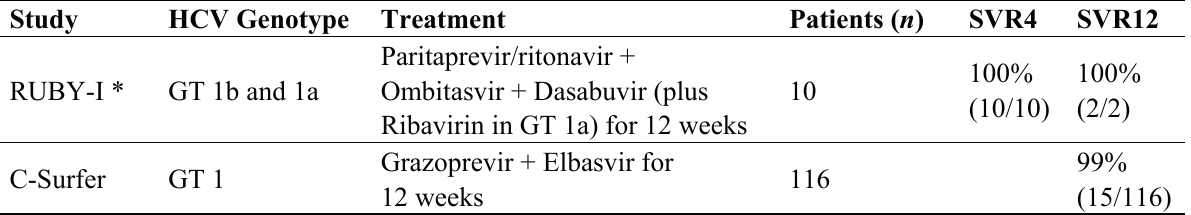
Table 2. SVR4 and SVR12 rates of HCV treatment in CKD stages 4/5 according